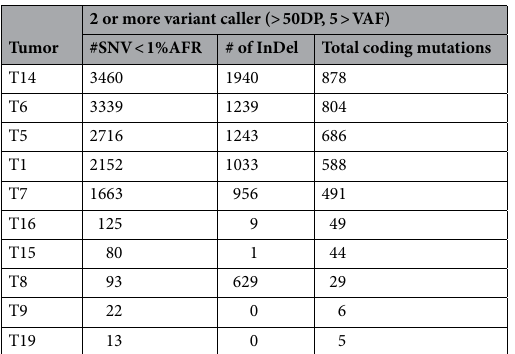
Table 1. Number of mutations* in each tumor sample. *Mutations called by two or more algorithms, filtered for rare (< 1% MAF) African population frequency, and sorted by somatic nonsynonymous coding mutations.